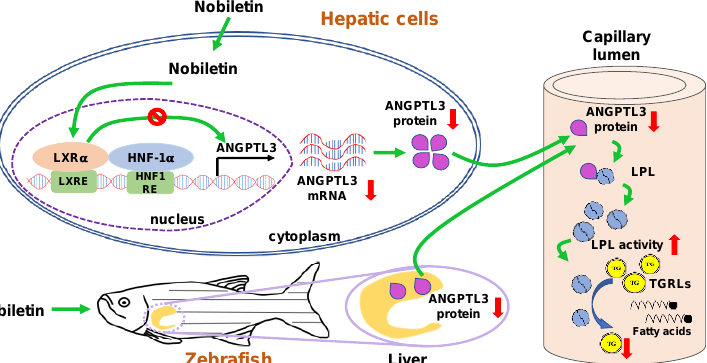
Figure 8. A hypothetical mechanism by which nobiletin regulates lipid metabolism through mod- ulation of the LXRα -ANGPTL3-LPL axis in vitro and in vivo. In vitro, nobiletin downregulates the mRNA and protein expression of ANGPTL3 in hepatic cell lines by counteracting the activation of LXRα, thereby reducing ANGPTL3 secretion and leading to increased LPL activity in the capillary lumen. In vivo, hepatic ANGPTL3 protein levels are alleviated in HFD-fed, nobiletin-treated zebrafish and potentially enhance the clearance of TGRLs and reduce TG accumulation in circula- tion.